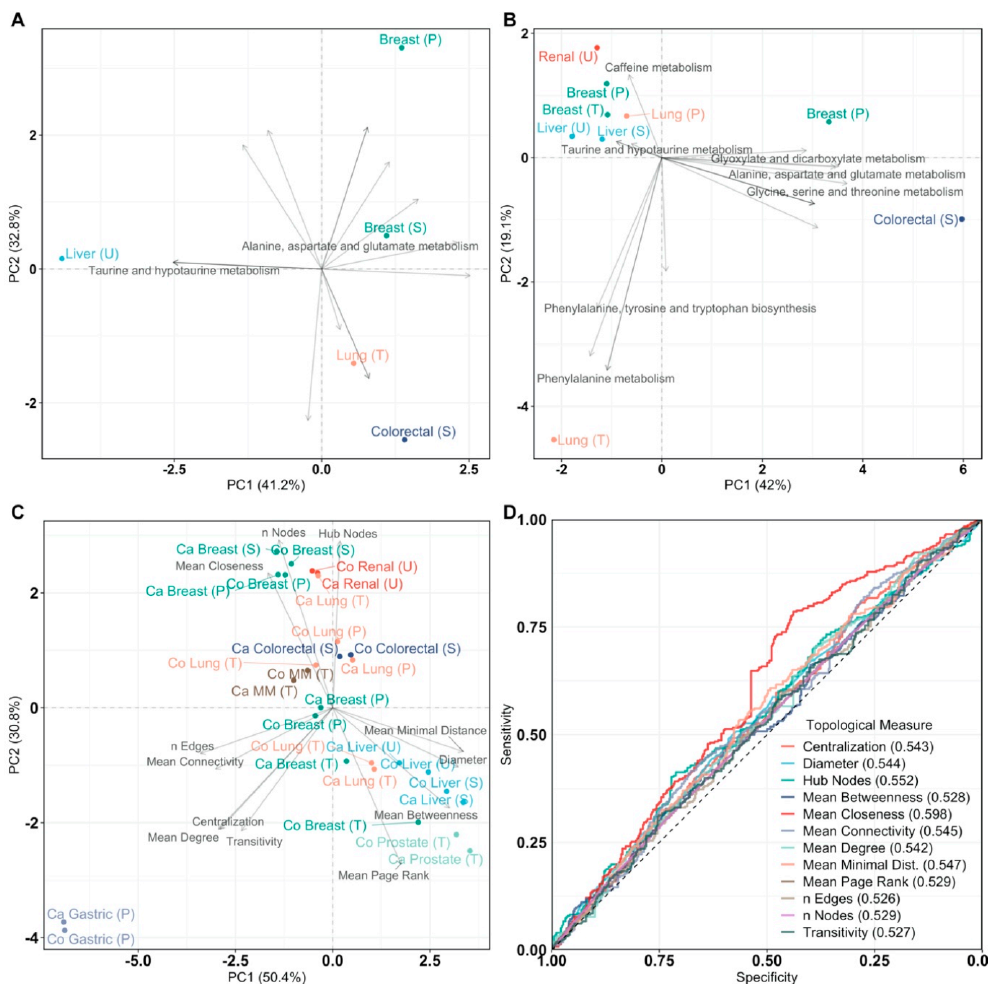
Figure 2. Principal Component Analysis (PCA) of pathway impact and network analysis. PCA labels are colored according to their cancer type and PCA loadings are labeled if they have a pathway impact score > 0.5. Sample origin is labeled as T, U, S, P for tissue, urine, serum, and plasma, respectively. Multiple myeloma is abbreviated as MM. ( A ) PCA biplot of pathway impact based on differentially abundant metabolites per cancer type; ( B ) PCA biplot of pathway impact based on differentially connected metabolites per cancer type; ( C ) PCA biplot of topological network measures per cancer type for all inferred metabolite association networks. Here, networks inferred from cancer or control samples are labeled as “Ca” and “Co”, respectively; ( D ) receiver operating characteristic curves of topological measures predicting cancer pathology on metabolite association networks (n = 28, 14/14). Predictions are based on logistic regression, cross- validated with leave-one-out cross-validation. The Area Under the Curve (AUC), 95% confidence interval (CI), and p -value of all topological measures are Nodes: AUC = 0.529, 95% CI = 0.488–0.570, p = 0.170, Edges: AUC = 0.526, 95% CI = 0.485–0.567, p = 0.216, Mean Connectivity: AUC = 0.545, 95% CI = 0.504–0.586, p = 0.0302, Mean Degree: AUC = 0.542, 95% CI = 0.501–0.583, p = 0.0470, Mean Closeness: AUC = 0.598, 95% CI = 0.557–0.638, p = 2.20 × 10 − 6 , Mean Betweenness: AUC = 0.528, 95% CI = 0.487–0.570, p = 0.175, Diameter: AUC = 0.544, 95% CI = 0.503–0.585, p = 0.0369, Mean Minimal Distance: AUC = 0.547, 95% CI = 0.506–0.588, p = 0.0244, Mean Page Rank: AUC = 0.529, 95% CI = 0.488–0.570, p = 0.165, Hub Nodes: AUC = 0.552, 95% CI = 0.511–0.593, p = 0.0137, Centralization: AUC = 0.543, 95% CI = 0.502–0.584, p = 0.0422, and Transitivity: AUC = 0.527, 95% CI = 0.486–0.568, p = 0.196. Definitions of topological measures are given in